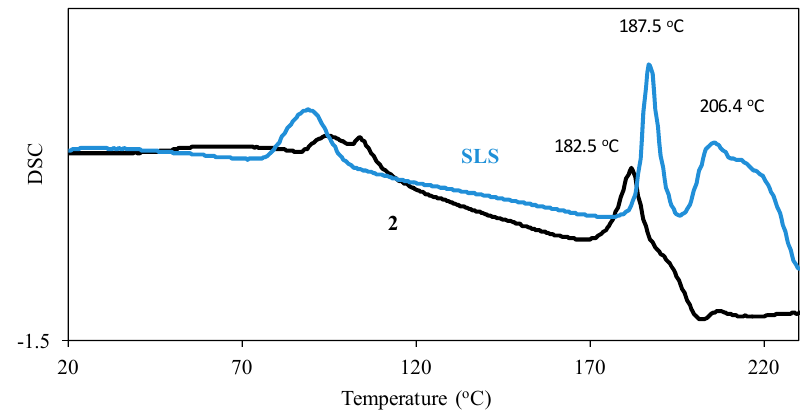
Figure 4. DSC thermograms of SLS and 2 .